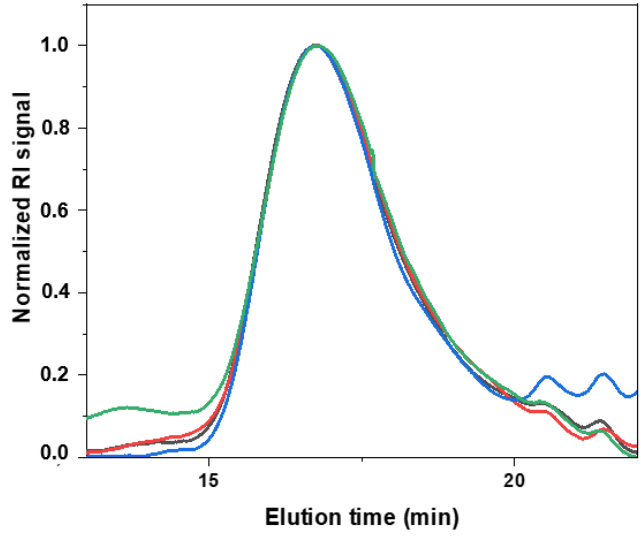
Figure 6. GPC spectra of the processed and untreated polymer under ultrasound. Data obtained for PLGA pure powder untreated (black), PLGA dissolved in the organic solvent (green), and PLGA treated under probe (red) and inline (blue) ultrasound technologies are presented. Table 6. Weight (Mw) and number (Mn) averaged molecular weight and PDI (Mw/Mn) of PLGA polymer treated and untreated via ultrasound. Significance of the difference ( p < 0.05) among the compared groups was determined with regards to the unprocessed PLGA powder.